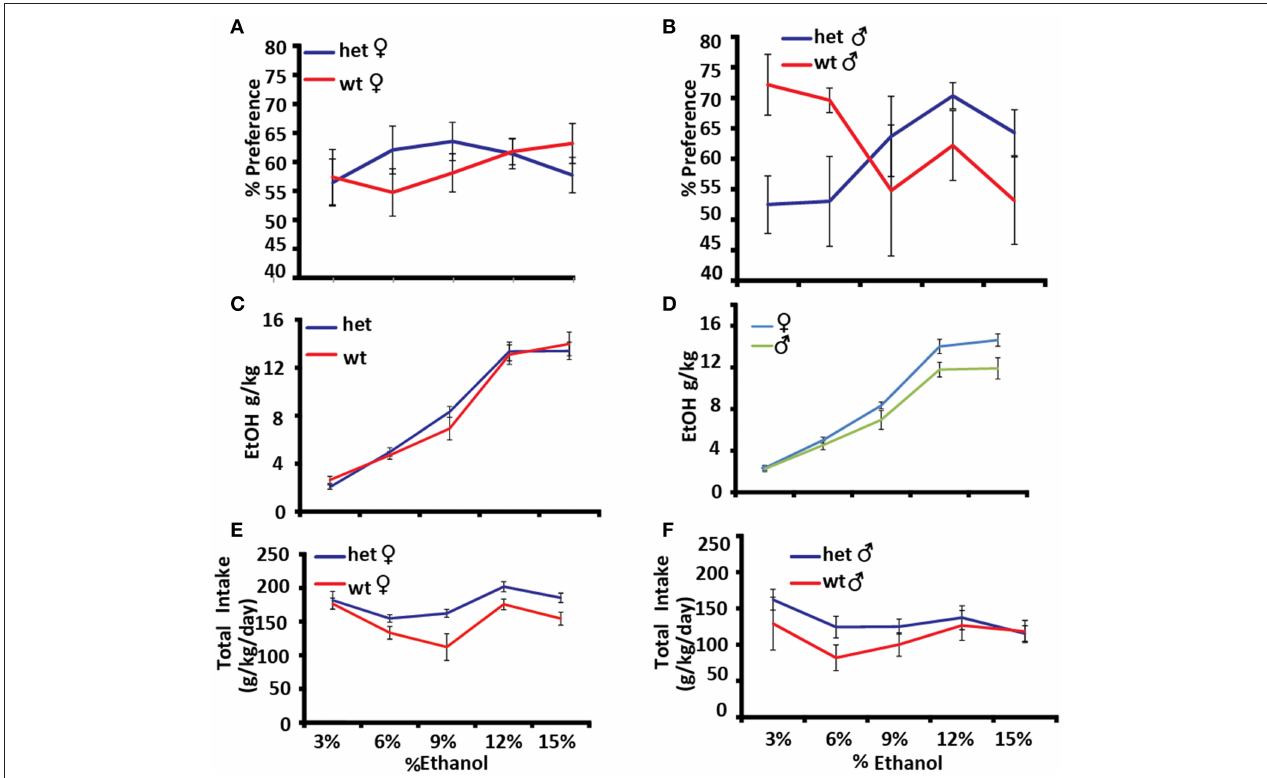
FIGURE 5 | Effects of Pafah1b1 heterozygous knock-out on alcohol preference. Alcohol preference was measured using the two-bottle choice paradigm for 4 days at increasing concentrations of ethanol (3, 6, 9, 12, and 15%). (A) Alcohol preference expressed as a percentage of alcohol consumed divided by total fluid intake in females. (B) Alcohol preference expressed as a percentage of alcohol consumed divided by total fluid intake in males. (C) Alcohol consumed as g/kg in Pafah1b1 mutants and WT controls. (D) Alcohol consumed as g/kg in males and females. (E) Total fluid consumed as g/kg/day females. (F) Total fluid consumed as g/kg/day males. Means ± SEM are depicted (A,B) +/+ n = 13 , ± n = 16 , male and female (C–F) +/+ n = 10 , ± n = 13 , male and